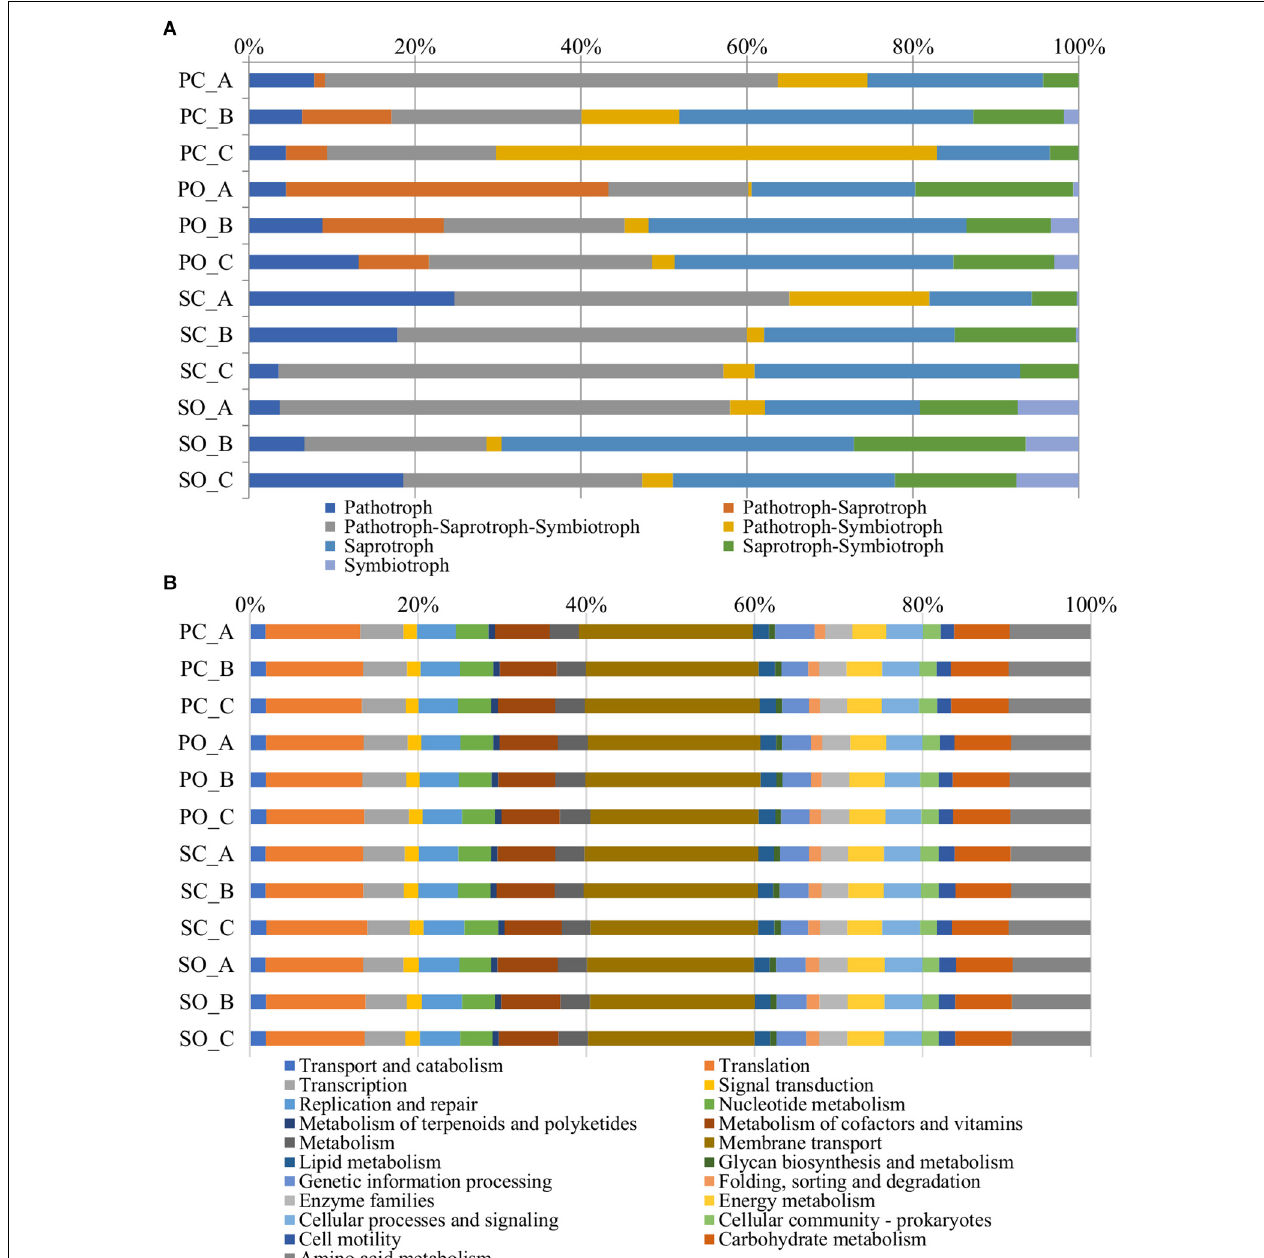
FIGURE 6 | Metagenome predicted functions classified using FUNGuild for fungi (A) and the Kyoto Encyclopedia of Genes and Genomes (KEGG) level 2 database in PICRUSt software for bacteria (B) showing the most abundant functions throughout the rhizospheric soil samples.